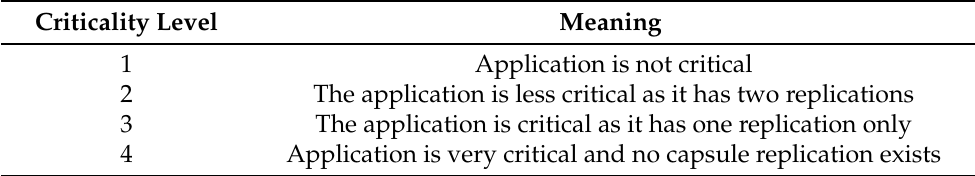
Table 3. Criticality levels.